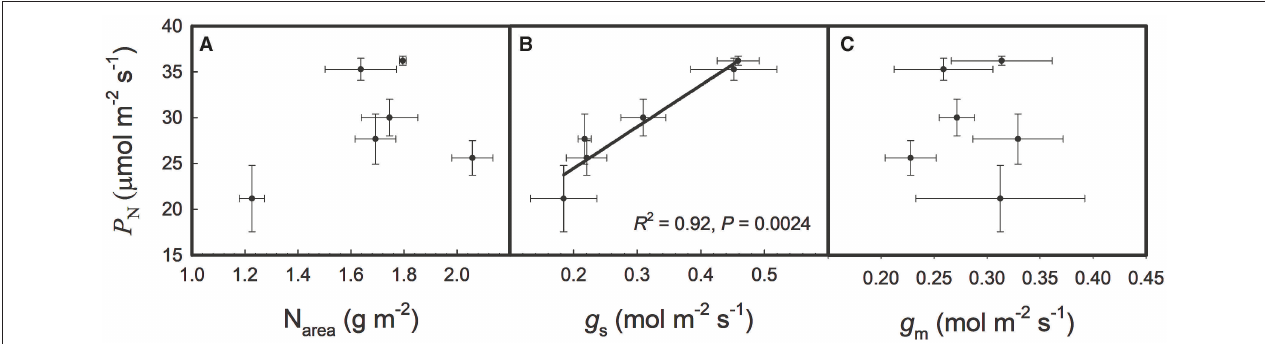
FIGURE 1 | Relationships of net photosynthetic rate (P N ) with: (A) area-based leaf nitrogen content (N area ), (B) stomatal conductance (g s ), and (C) mesophyll conductance (g m ) across the six rice genotypes. Data are shown as the means ± SD of three